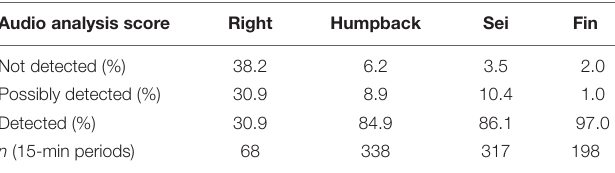
TABLE 3 | Audio analysis scores for 15-min tally periods scored as “possibly detected” in near real